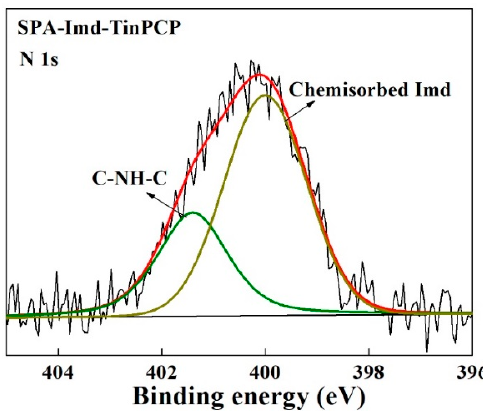
Figure 3. XPS spectrum of N 1s of SPA-Imd-TinPCP.